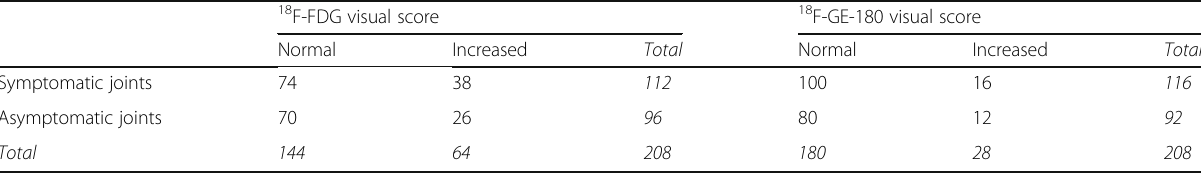
Table 3 Cross-tabulation of PET-CT visual score and clinical status